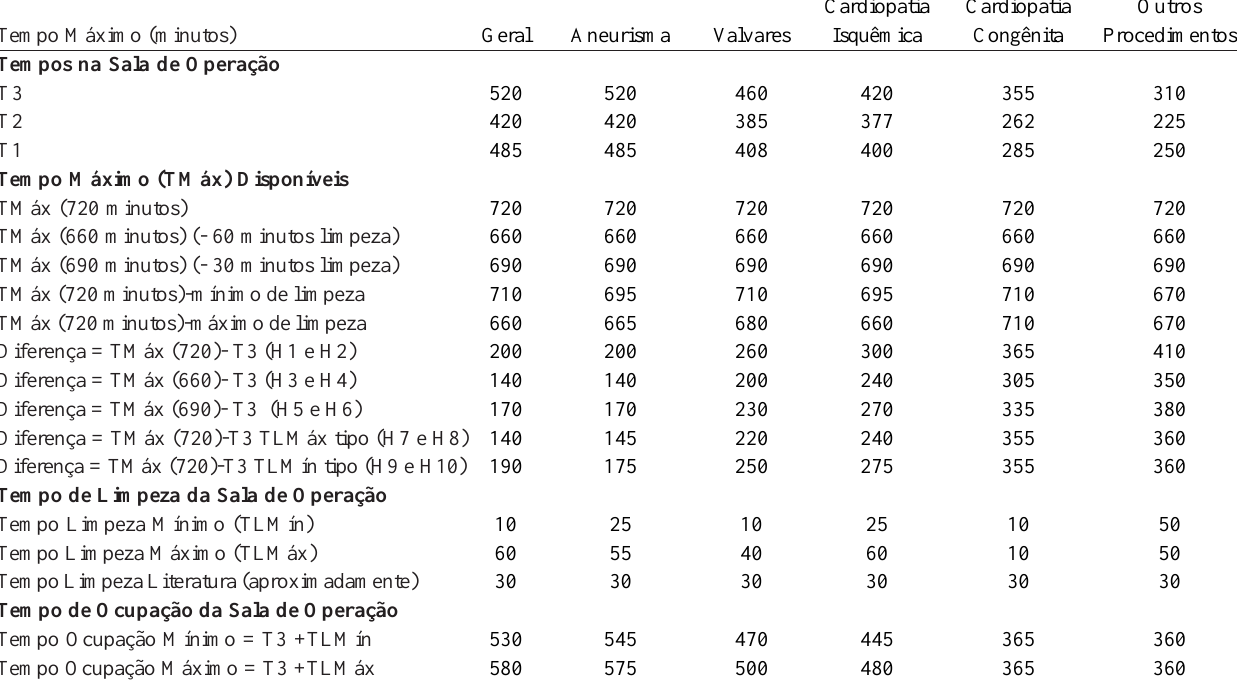
Quadro 2.Tempos máximos na sala de operação (minutos) : T1: Tempo Real da Operação; T2: Tempo Exato da Operação; T3: Tempo da Presença do Doente na Sala de Operação.